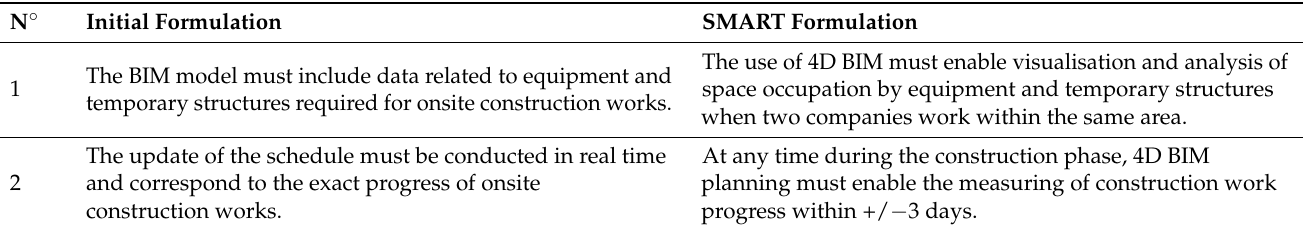
Table 1. Phase 1: Expression of 4D objectives in the BIM specification